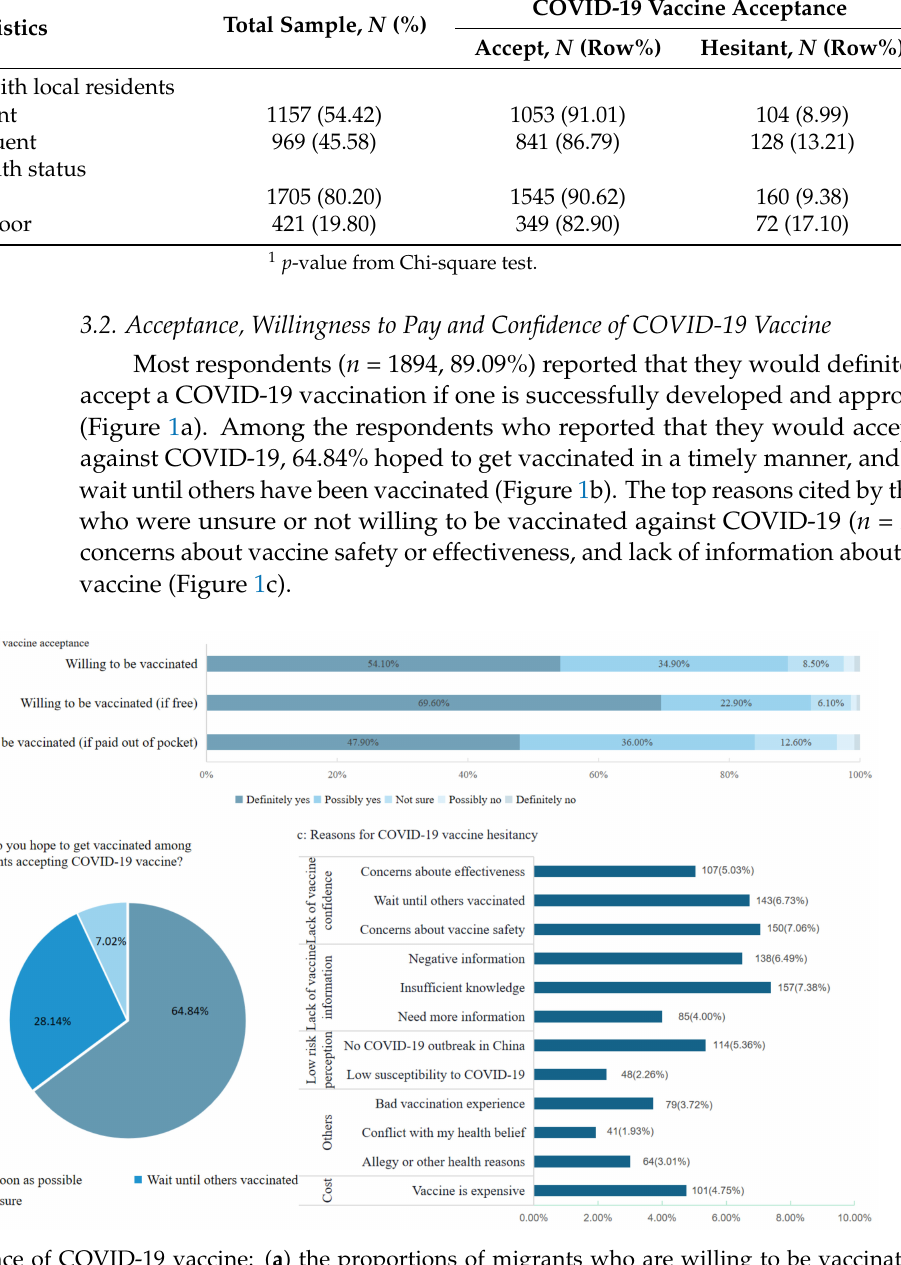
Figure 1. Acceptance of COVID-19 vaccine: ( a ) the proportions of migrants who are willing to be vaccinated against COVID-19; ( b ) When migrants hope to get vaccinated for respondents who are willing to be vaccinated against COVID- 19; ( c ) Reasons for COVID-19 vaccine hesitancy for respondents who are unwilling or unsure to be vaccinated against